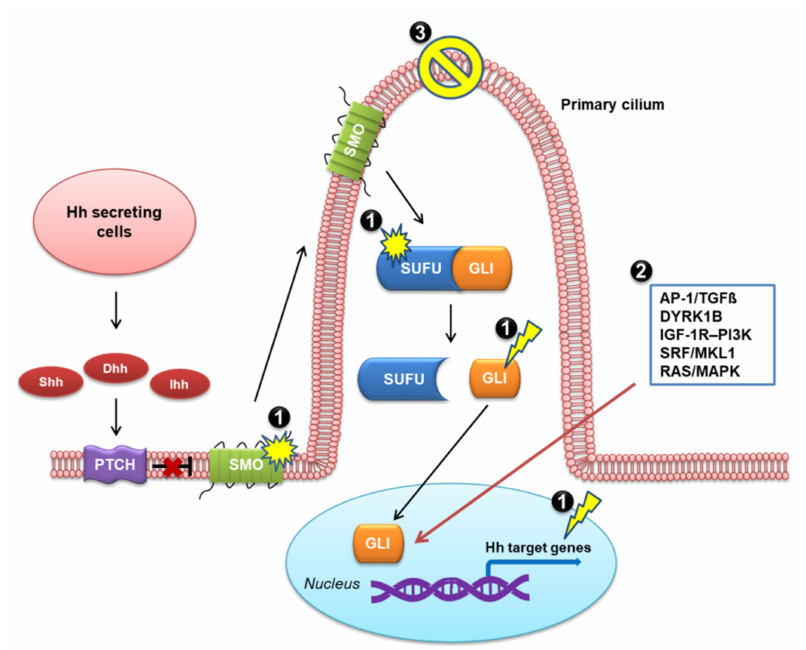
Figure 5. Mechanisms of resistance to SMO inhibitors, including: (1) genetic mutations including SMO mutation, loss of SUFU, and amplification of GLI or Hh target genes; (2) activation of non- canonical Hh pathway; and (3) loss of primary cilia. The black arrows indicate the canonical Hh pathway, and the red arrow indicates the non-canonical Hh